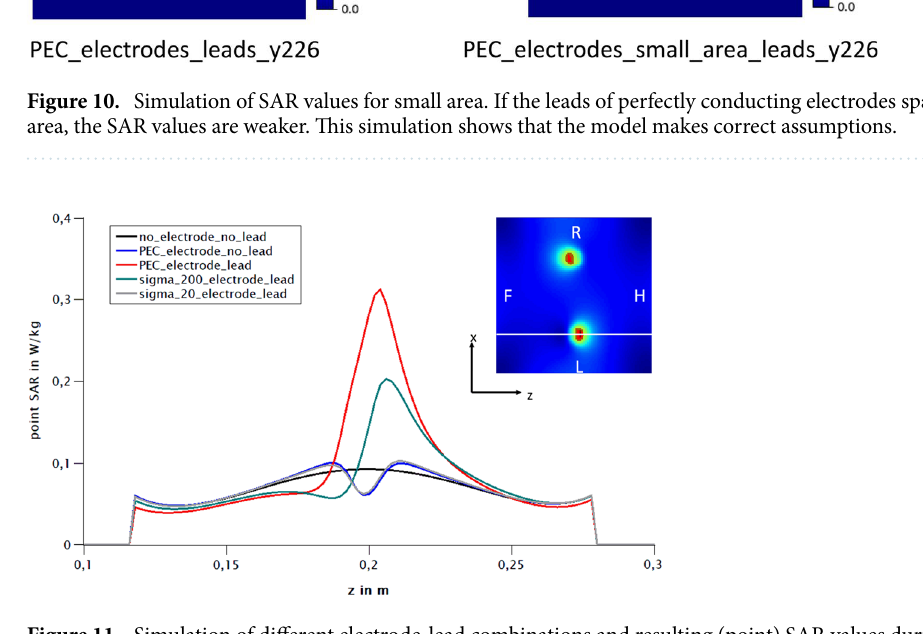
Figure 11. Simulation of different electrode-lead combinations and resulting (point) SAR values during MRI at B 1rms of 0.86 µT (see 10 ). SAR values along the z-plane as expected, a lead loop increases the SAR value. The increase of SAR is in this case proportional to the conductivity (perfect electric conductor [PEC] > Sigma 200 > Sigma20). Without wire loop, none of the electrodes shows increased SAR values. The small image on the top right shows a simulation as a heat map. The section plane for the line diagram is drawn in white. F stands for foot, H for head, R for right and L for